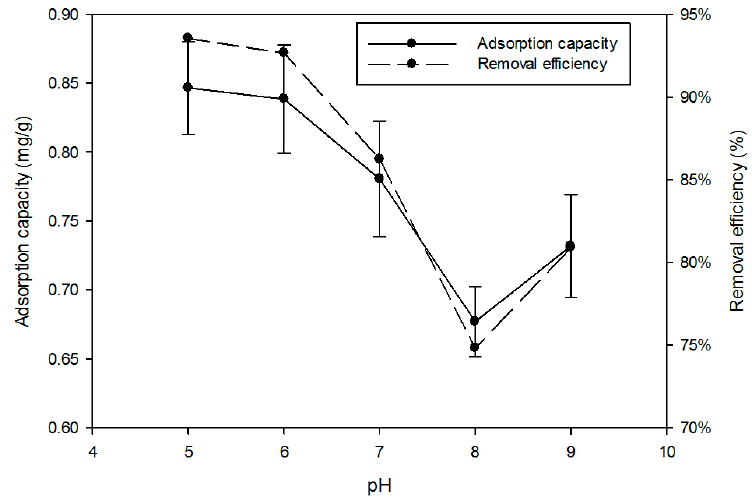
Figure 2. Effect of pH of solution on sorption of P. Dose of media 2 g; initial P concentration 2 mg/L; contact time 24 h; agitator 180-rpm.